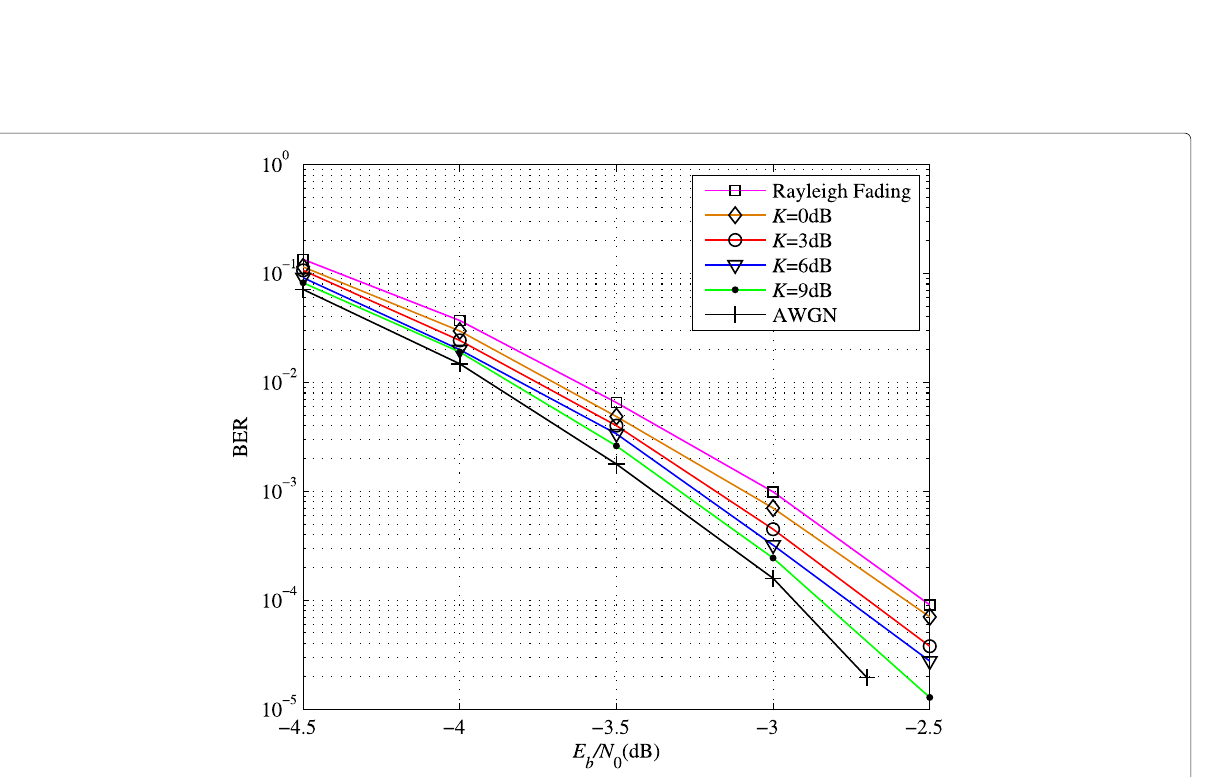
Fig. 5 BER performance of polar-coded STTD system corresponding to 4 × 2 MIMO. The bit error rate performance of polar-coded STTD system with four transmit antennas and two receive antennas. The Rician K -factors are various, which include the positive infinity (AWGN) and negative infinity